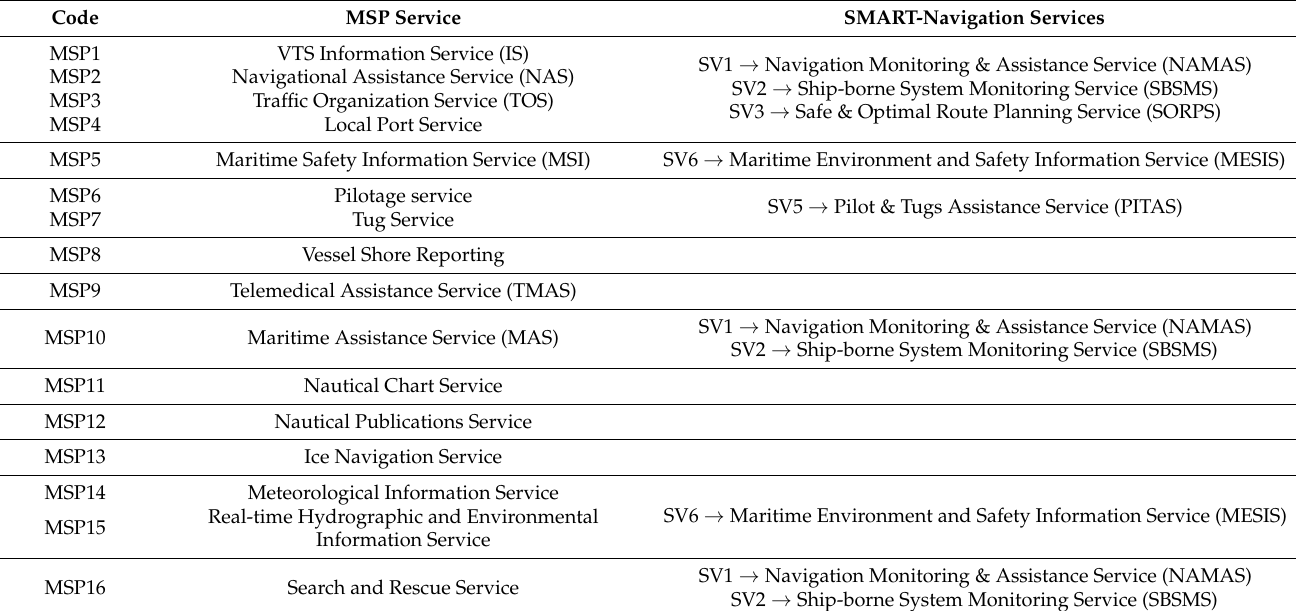
Table 1. Maritime Service Portfolios (MSPs) linked to SMART-Navigation